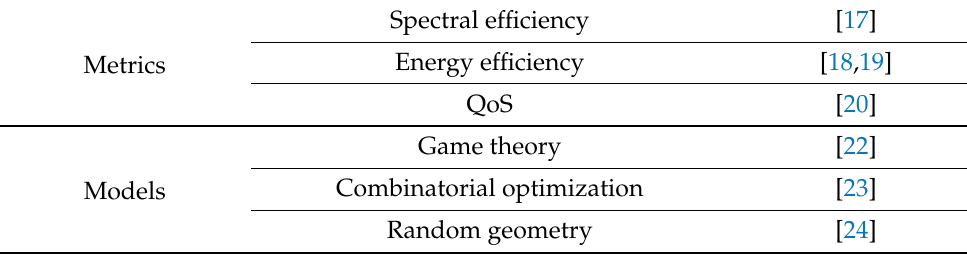
Table 1. Common metrics and models for user-BS selection strategy